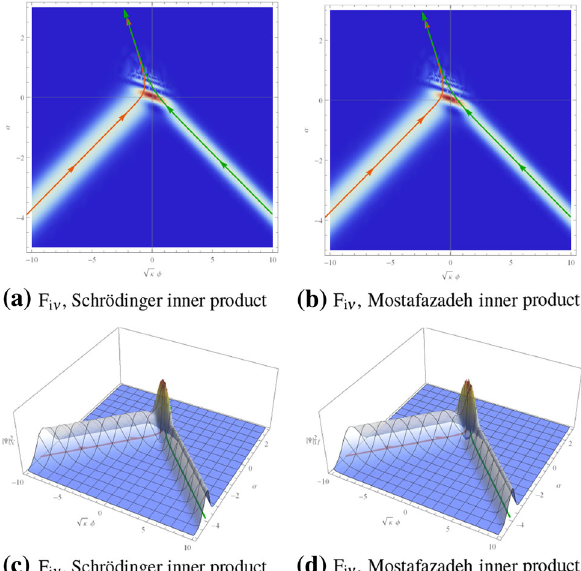
Fig. 2 Wave packets and the corresponding classical trajectories for quintessence with m x V < 0. Parameters are V = + 1, λ = 4 / 5, ¯ ω = − 35 / 8 and Γ = 7 /